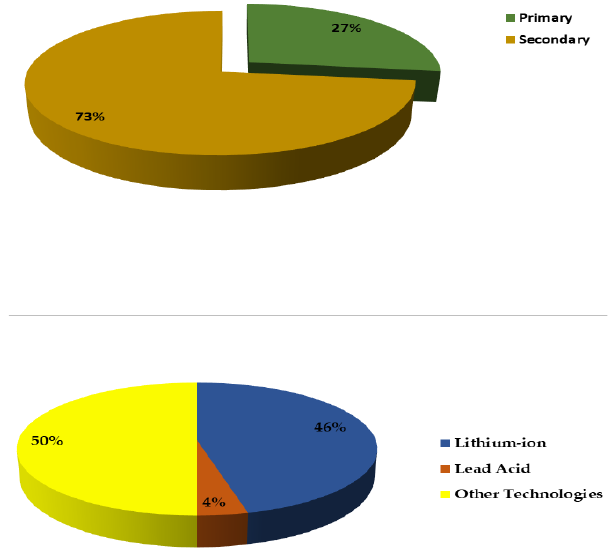
Figure 10. Market share of various types of batteries worldwide.